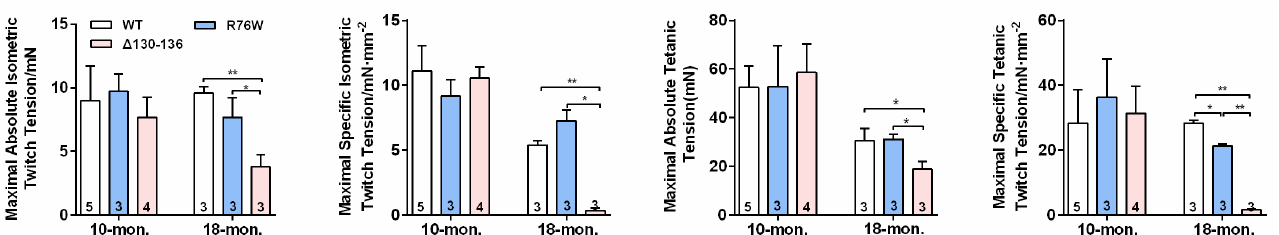
Figure 4 . Impairment of Cx43 HCs decreases SL muscle contractile force in 18-month-old mice. ( a – d ) Maximal absolute isometric twitch tension ( a ), maximal specific isometric twitch tension ( b ), maximal absolute tetanic tension ( c ) and maximal specific tetanic tension ( d ) in SL muscles in 10- and 18-month-old transgenic mice and their WT littermates. Sample sizes are indicated at the bottom of each column. * p < 0.05; ** p < 0.01.